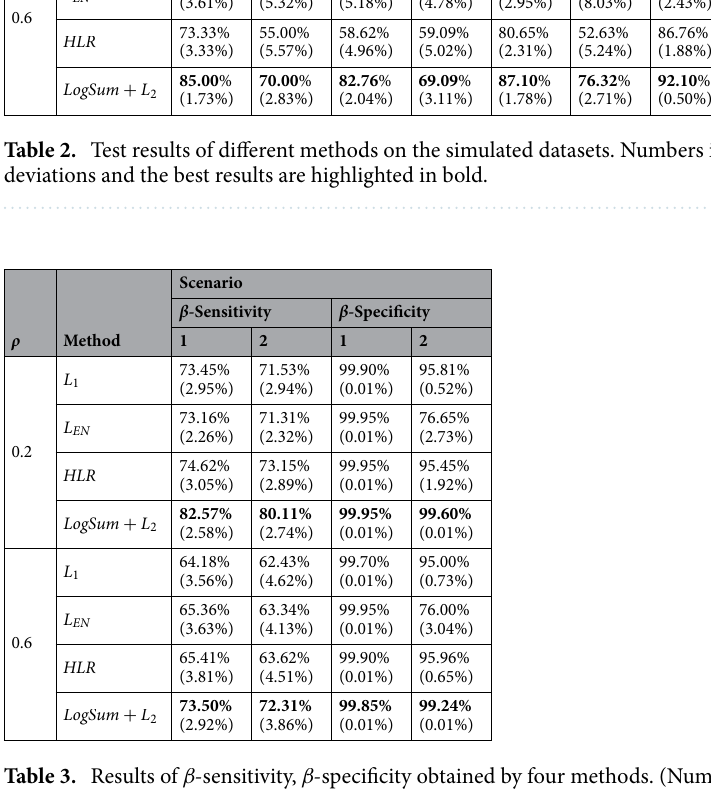
Table 3. Results of β -sensitivity, β -specificity obtained by four methods. (Numbers in parentheses are the standard deviations and the best results are highlighted in